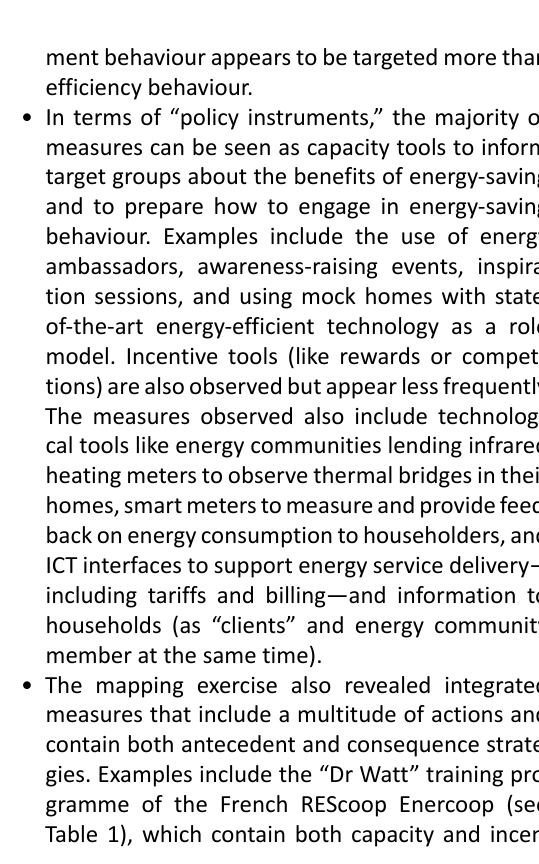
Figure 1. Research strategy to determine the effectiveness of REScoops to encourage their members to save energy. Source: Adapted from Coenen and Hoppe